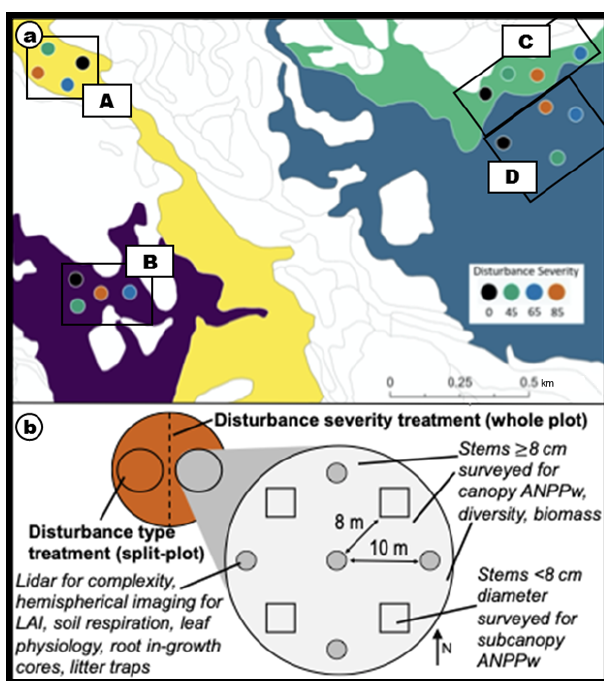
Figure 1. (a) Map showing the distribution of plots in relation to landform types (Pearsall, 1996; Table S1). Plot replicates are grouped (A, B, C, D) with colors indicating severity level; (b) sub- plot diagram showing position of nested subplots for sampling and arrangement of subplots within the plot